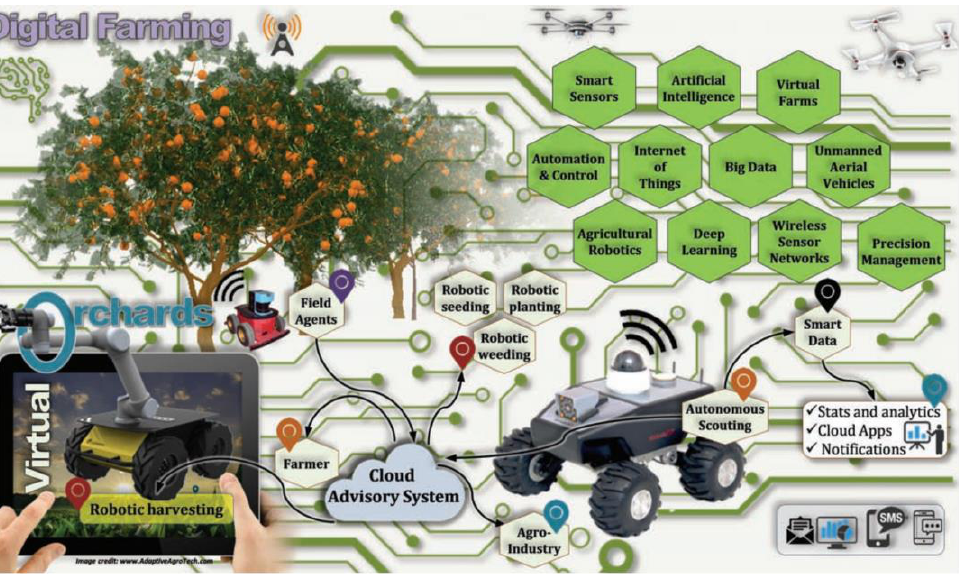
Figure 1. Digital farming with agricultural robotics (source: www.AdaptiveAgroTech.com (accessed on 1 October 2022)). Table 1. Comparison of frequently used sensors for fruit and vegetable recognition.